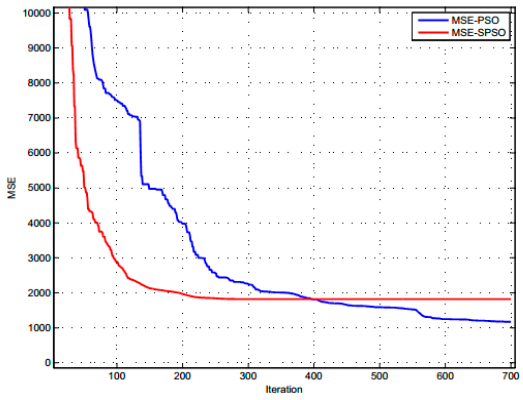
Figure 5. The value of MSE in all iterations with basic PSO and SPSO.